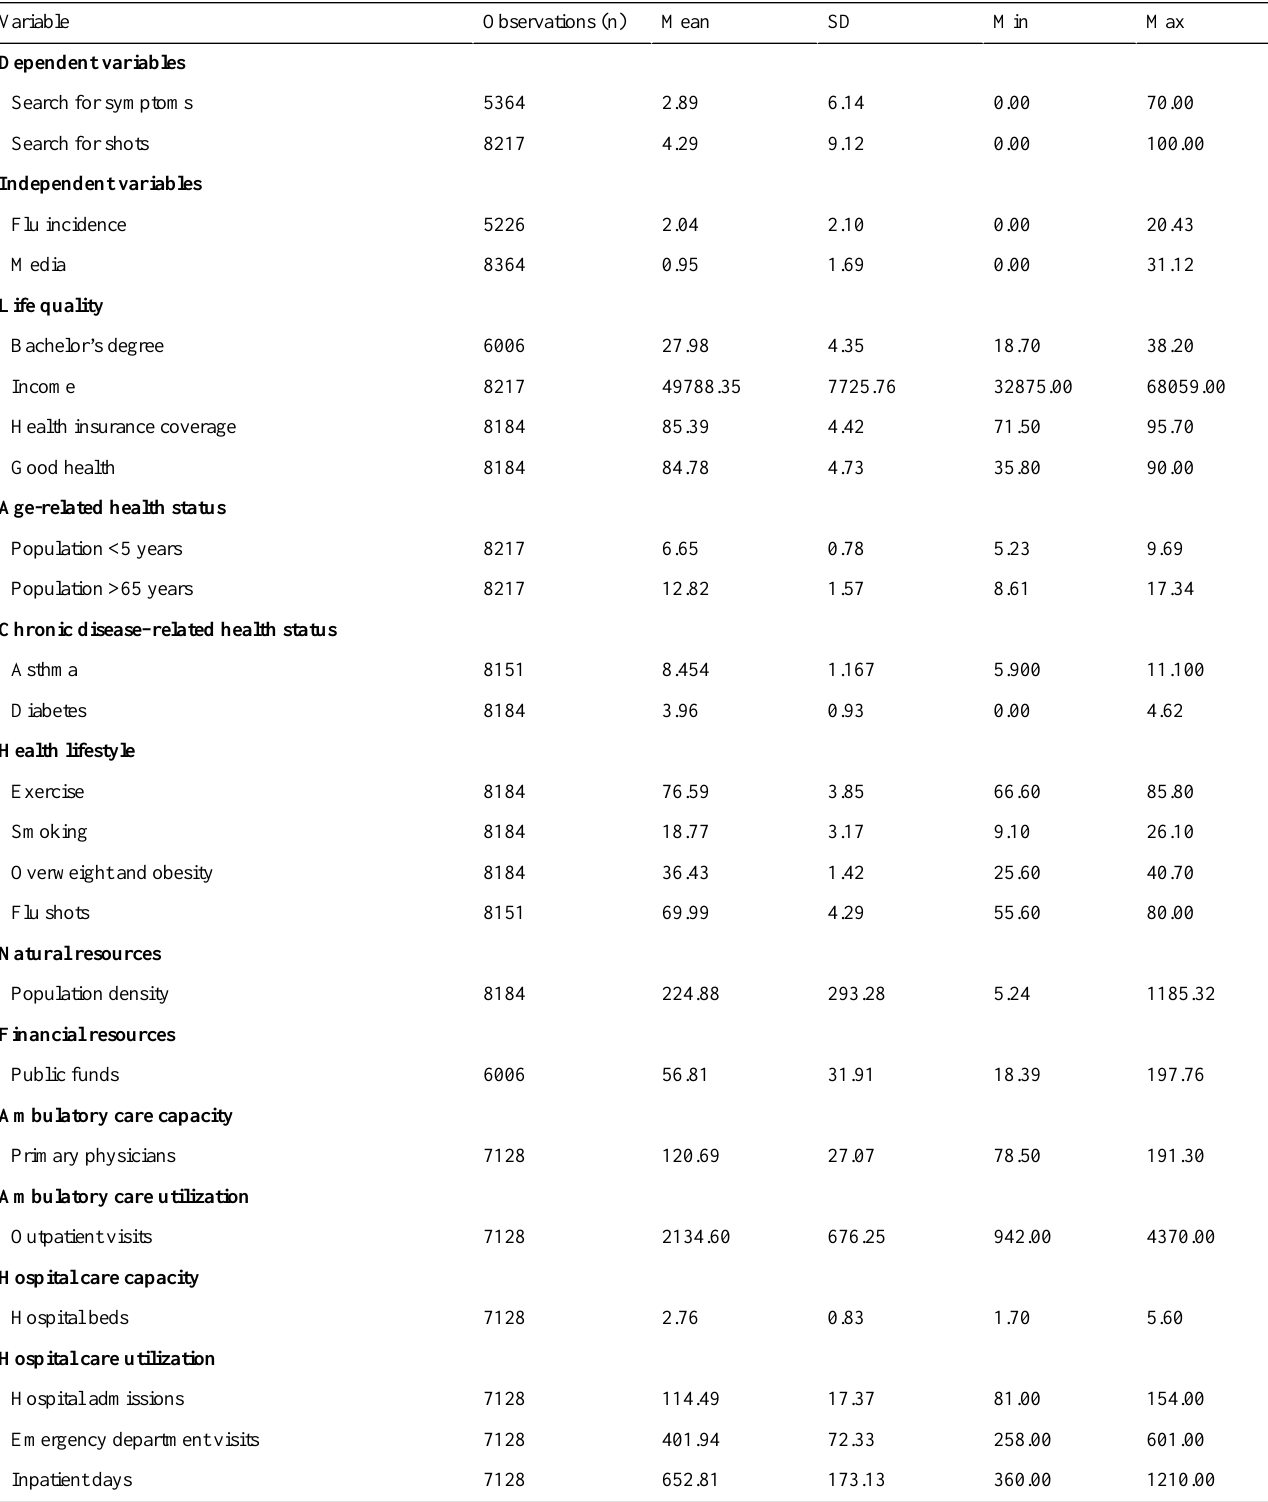
Table 3. Summary